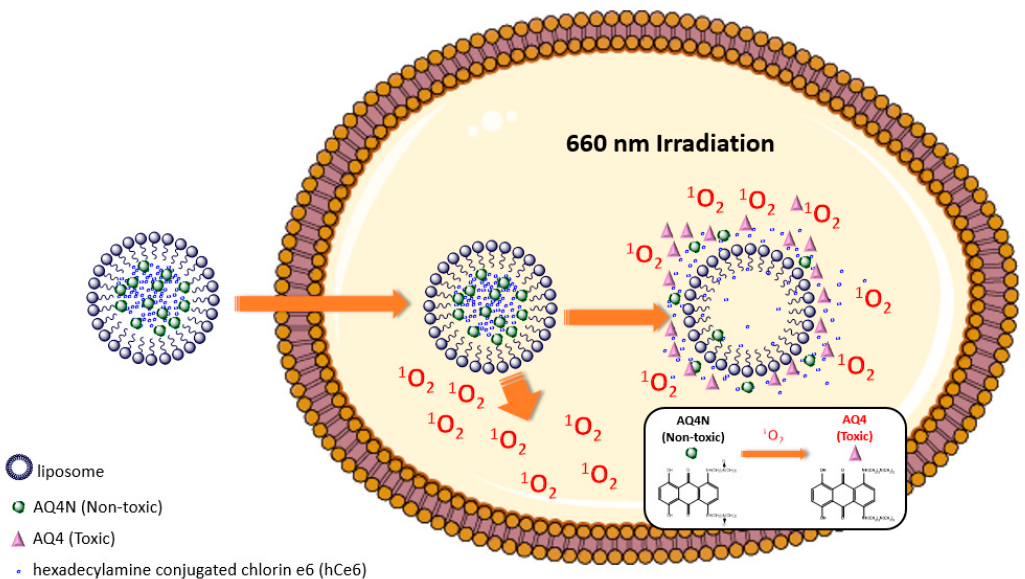
Figure 3. The singlet oxygen concentration was further enhanced by hCe6- hypoxia-activated prodrug (AQ4N)-liposome nanosystem irradiated by 660 nm laser and non-toxic AQ4N was transformed to toxic AQ4 by high concentration of singlet